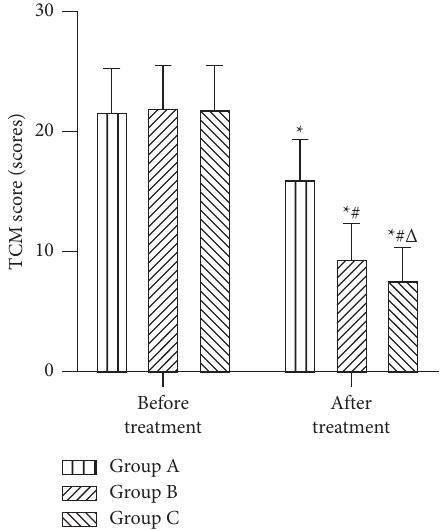
Figure 2: Comparison of 3 groups of TCM scores ( x ± s , scores). Compared with the same group before treatment, ∗ P < 0 . 05; compared with group A after treatment, # P < 0 . 05; compared with group B after treatment, Δ P < 0 .